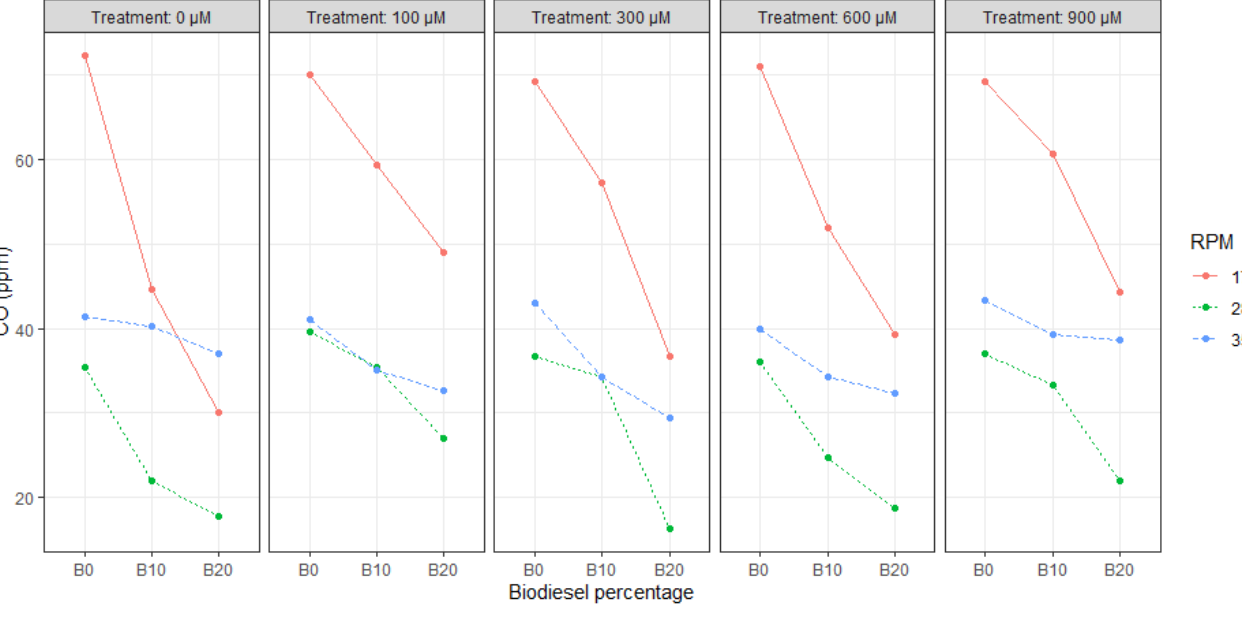
Figure 2. Correlation plot between CO, SA content, RPM, and biodiesel percentage.